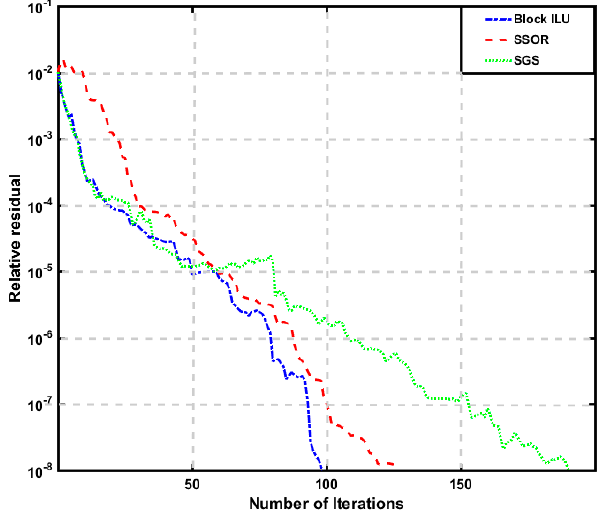
Figure 8. The convergence plot of various preconditioners with QMR for marine model 2.